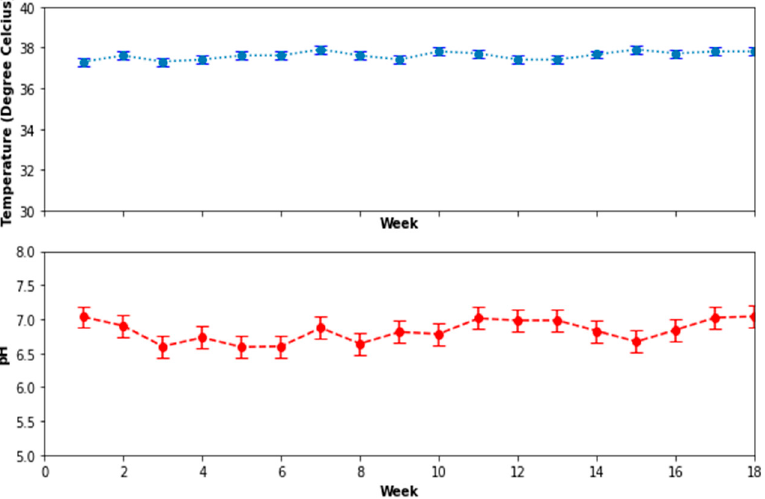
Figure 14. Variation of the pH and the temperature in the DEGBR during the processing of